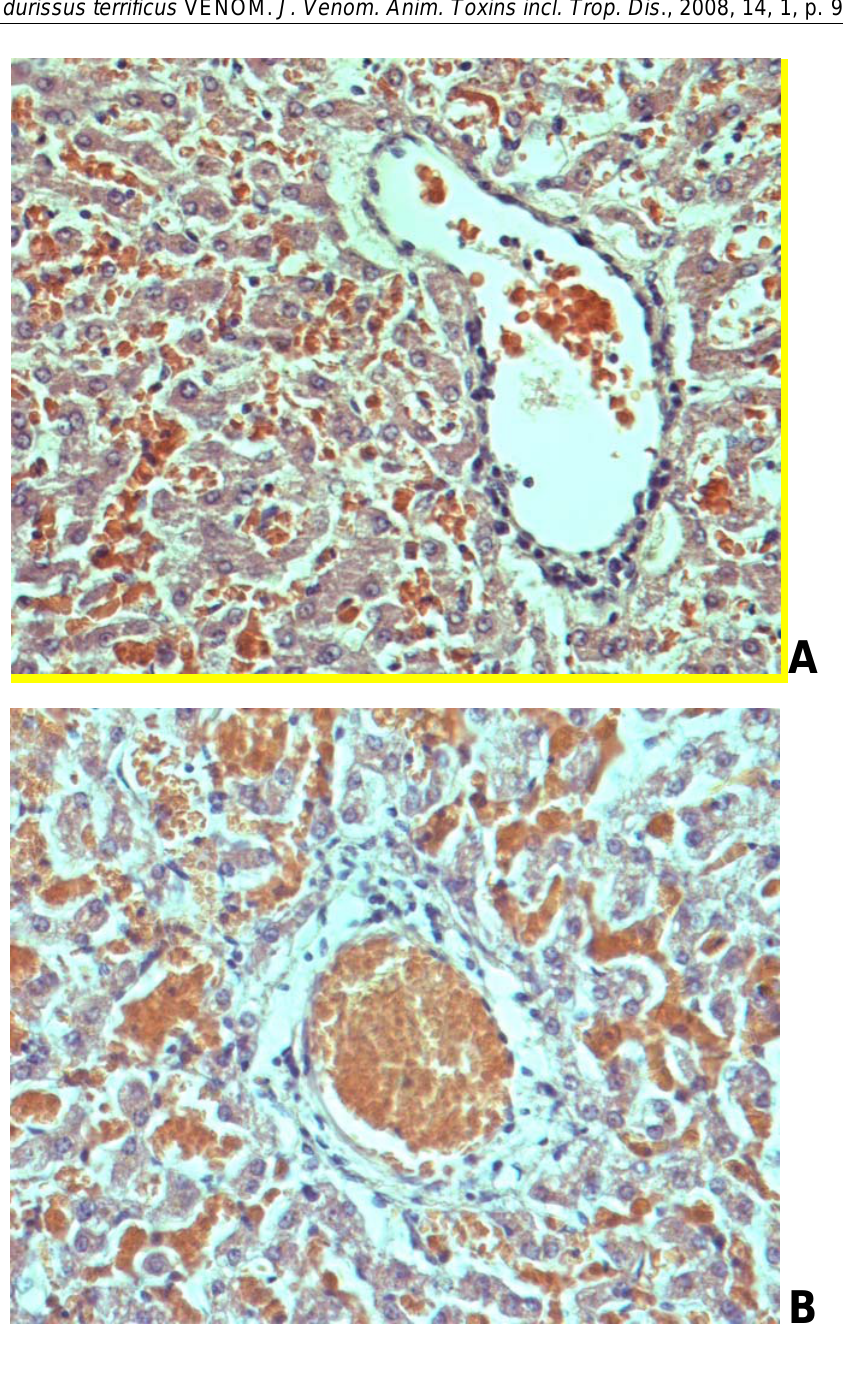
Figure 11. Microscopic aspect of the liver, showing congestion of hepatic sinusoids and centrilobular necrosis in dogs inoculated with crotalic venom. A: (HE, 400X), B: (HE,